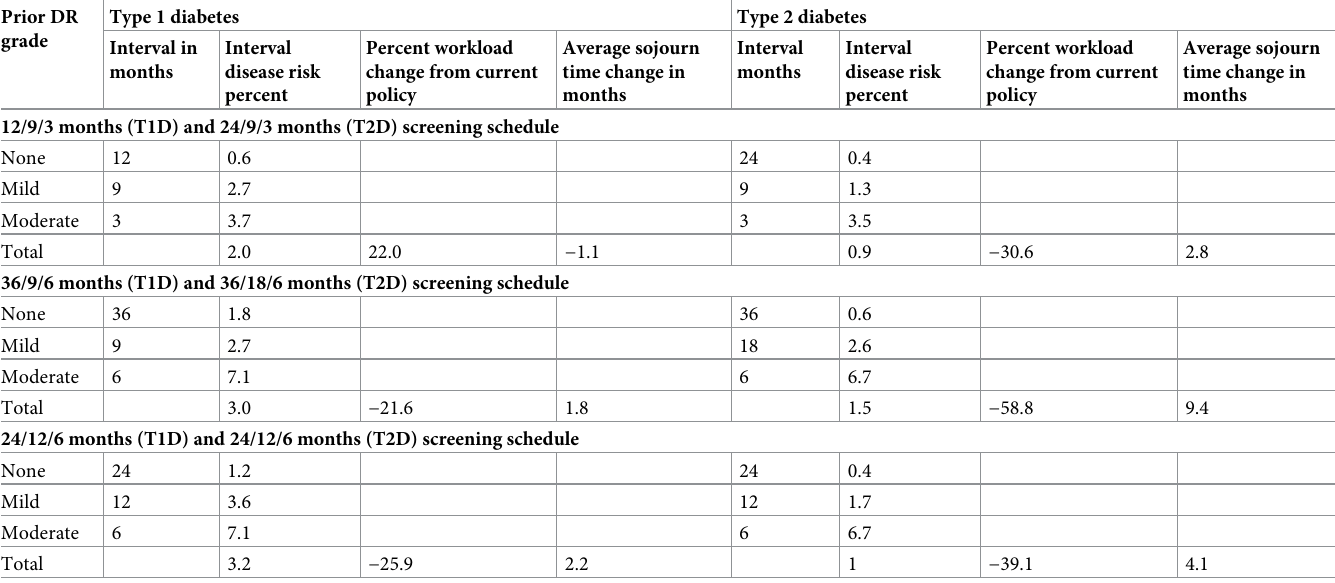
Table 4. Screening schedules using a range of potential different screening